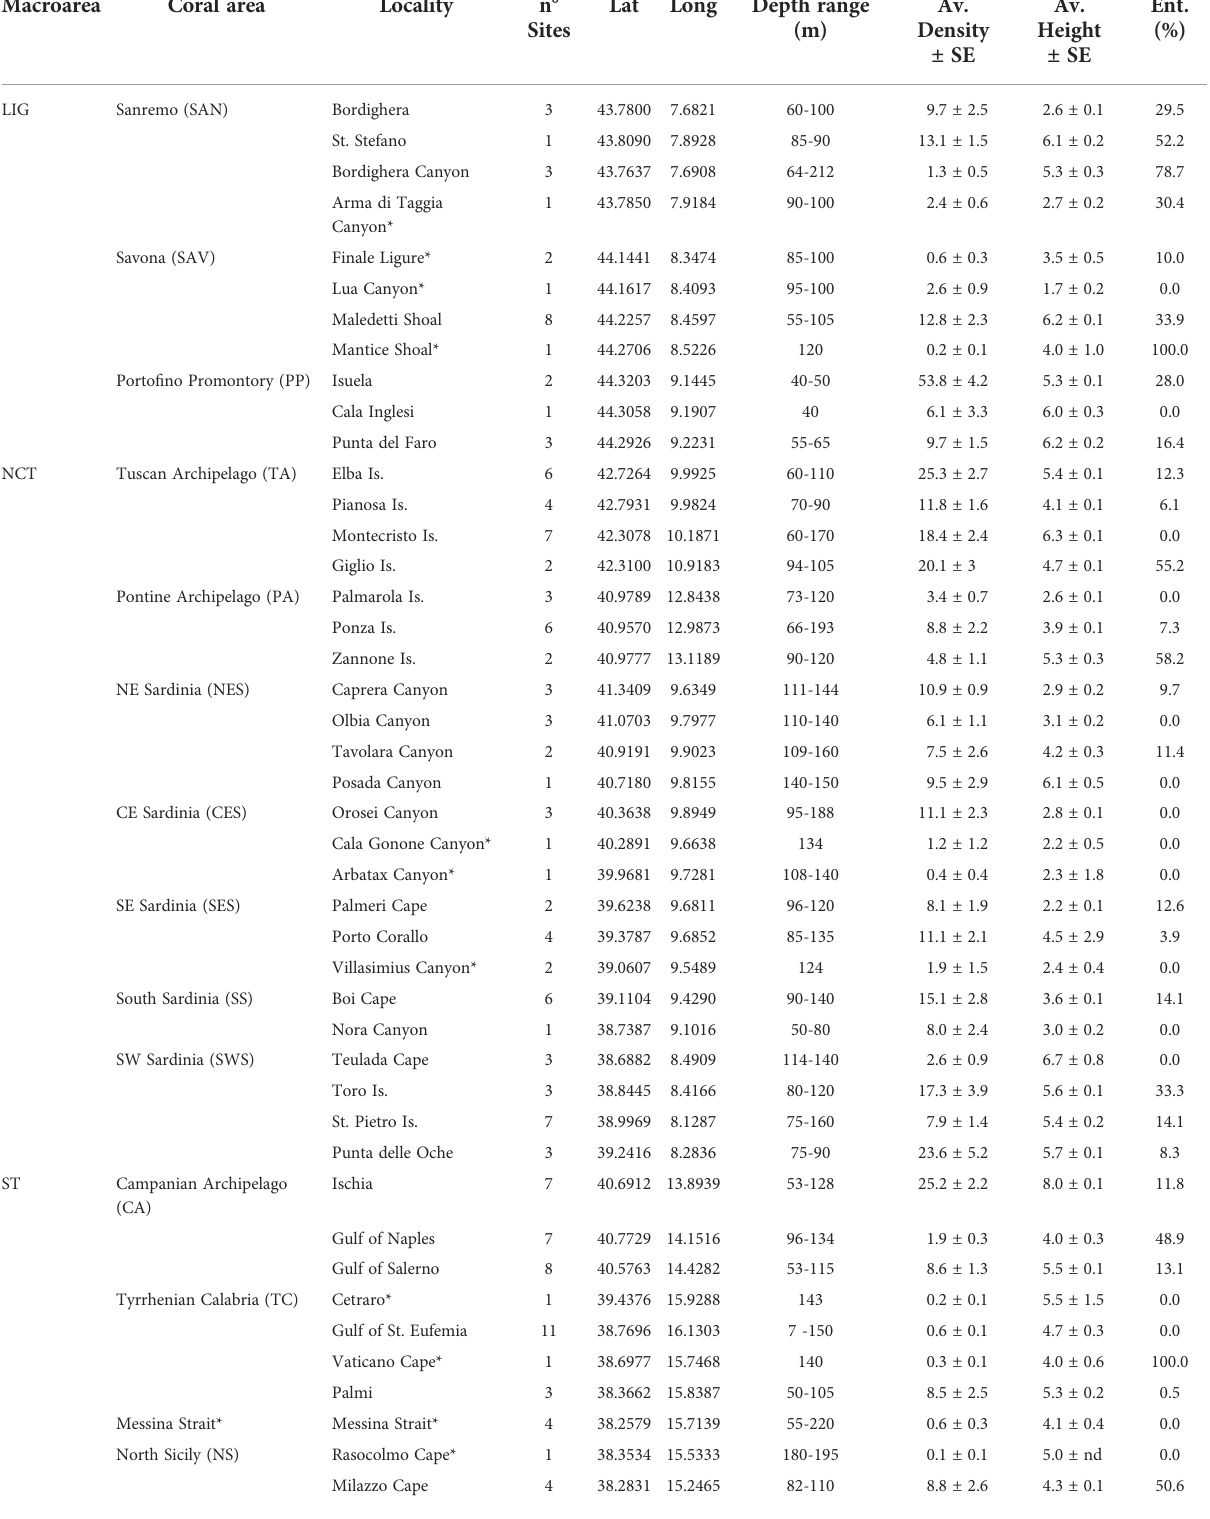
TABLE 1 Presence of Corallium rubrum along the Italian coast according to macro-area, coral areas (code in brackets), locality, number of sites per locality, latitude, and longitude of the centroid of the locality, depth range, average density and height, and percentage of entanglement of red coral populations in the